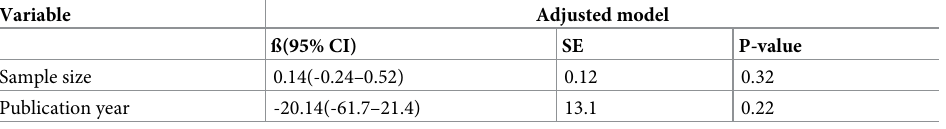
Table 2. Meta-regression analysis for year of study and sample size as a reason of heterogeneity on the knowledge estimates of women infected by HIV in Africa.